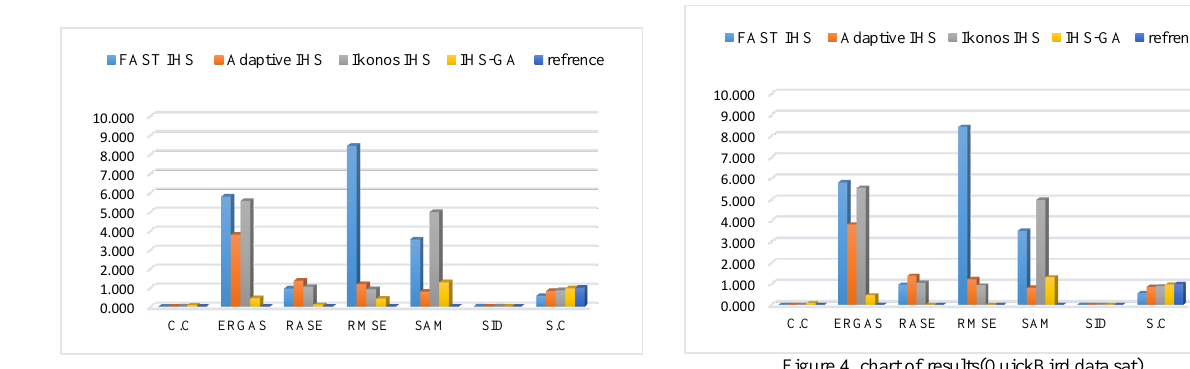
Figure 2. chart of results(IKONOS data sat)